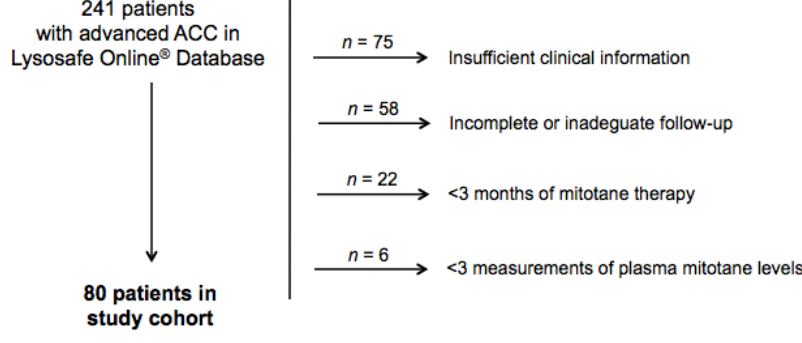
Figure 1. Study cohort. Figure 1. Study Table 1. Baseline features of patients.